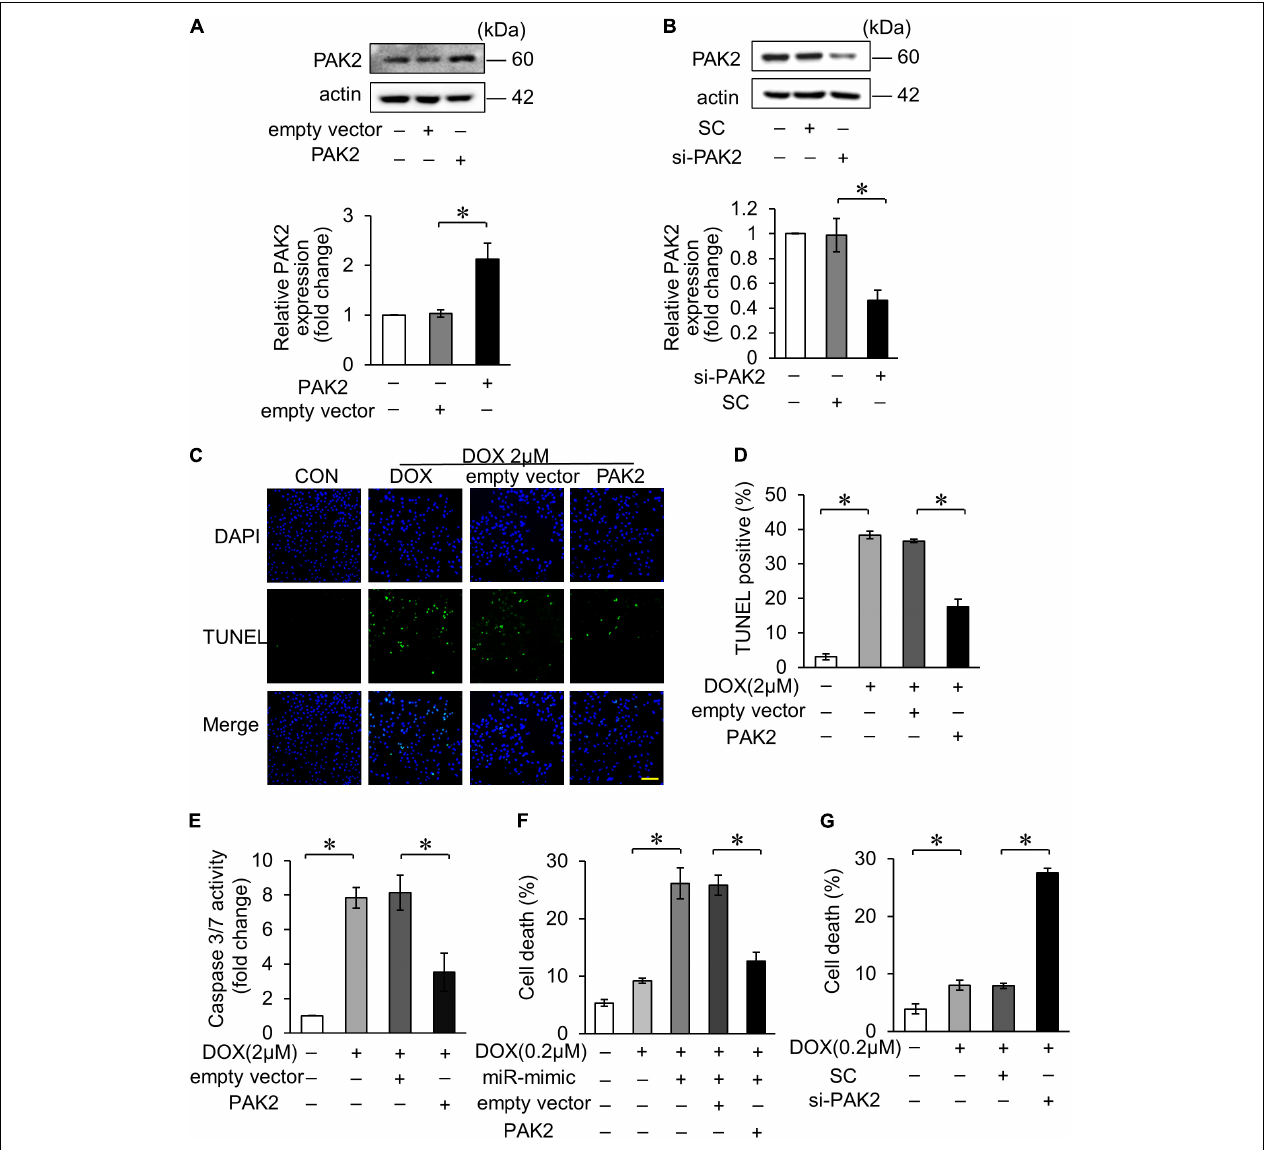
FIGURE 3 | PAK2 attenuated DOX-induced cardiomyocyte apoptosis. (A) H9c2 was transfected with PAK2-overexpressing plasmid for 24 h. The expression levels of PAK2 were detected by Western blot and the quantitative histogram was shown. (B) H9c2 was transfected with PAK2 small-interfering RNA (siRNA) for 24 h. The expression levels of PAK2 were detected by Western blot and the quantitative histogram was shown. (C–E) Enhanced PAK2 expression with PAK2-overexpressing plasmid for 24 h and exposed to 2 µ M DOX for 24 h. Apoptosis was detected by TUNEL assay (C) . Green, TUNEL-positive nuclei; blue, DAPI-stained nuclei; scale bar, 200 µ m. Statistical analysis of TUNEL-positive cells (D) and caspase-3/7 activity (E) are shown. (F) H9c2 was cotransfected with miR-194-5p mimic and PAK2-overexpressing plasmid for 24 h and then exposed to 0.2 µ M DOX for 24 h. Cell death rate was analyzed. (G) H9c2 was transfected with PAK2 siRNA for 24 h and exposed to 0.2 µ M DOX for 24 h. Cell death rate was analyzed. All the experiments have been performed independently in triplicate, and the data were expressed as mean ± SD. ∗ p < 0.01 as